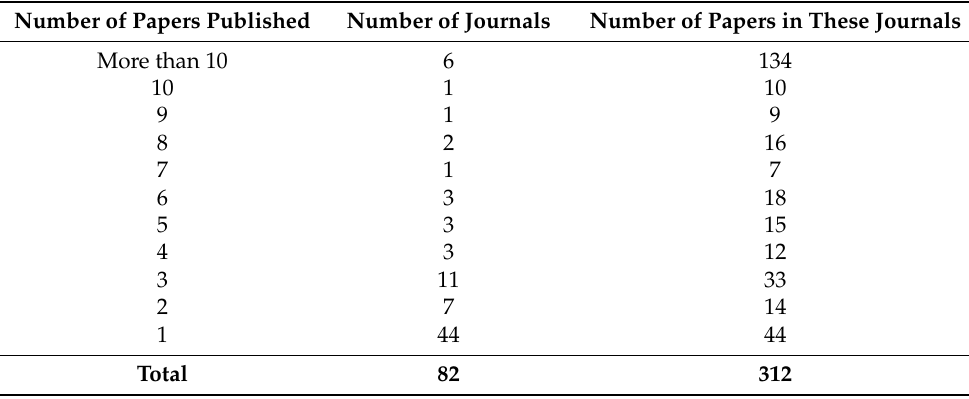
Table 5. Information on the number of journals and papers